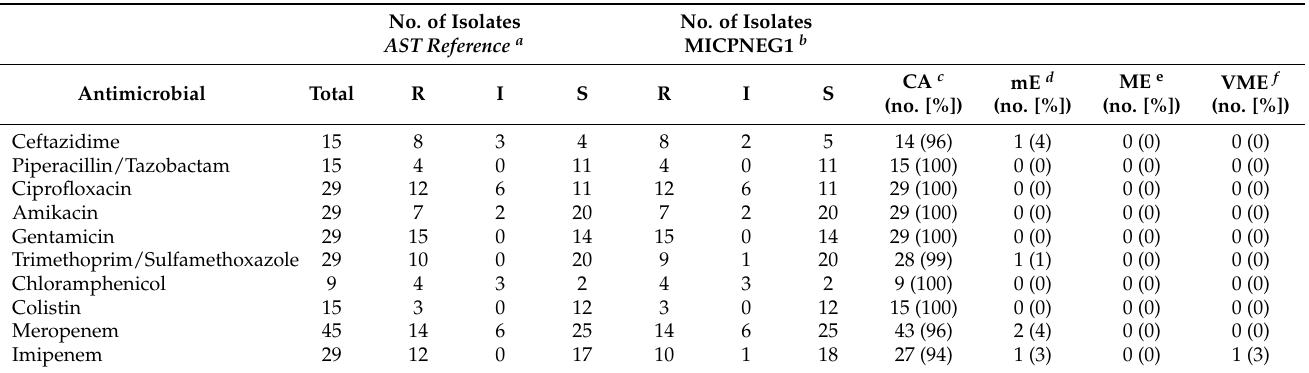
Table 5. Results for non-fermenting Gram-neg bacilli tested with the MICNEG1 standard turbidity inoculum method and visual reading versus AST reference methods.